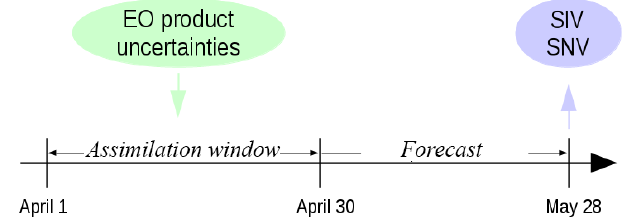
Figure 4. Timeline of assimilation and forecast